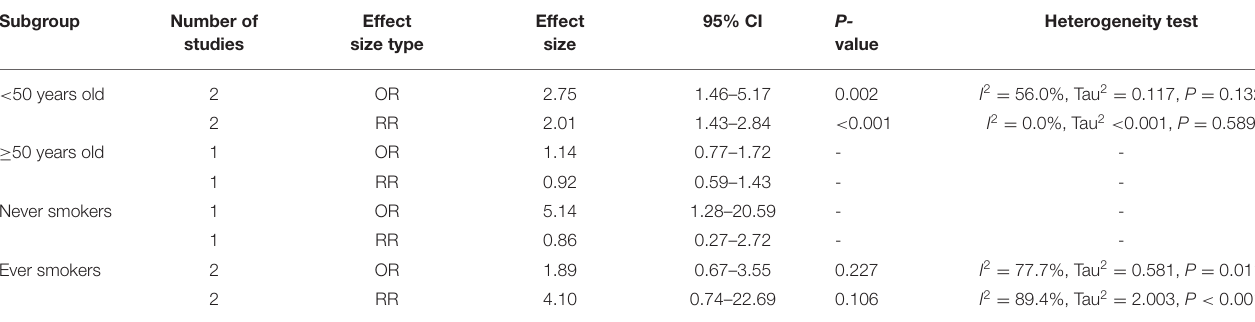
TABLE 3 | Association between non-obstructive chronic bronchitis and incident chronic obstructive pulmonary disease in subgroups.